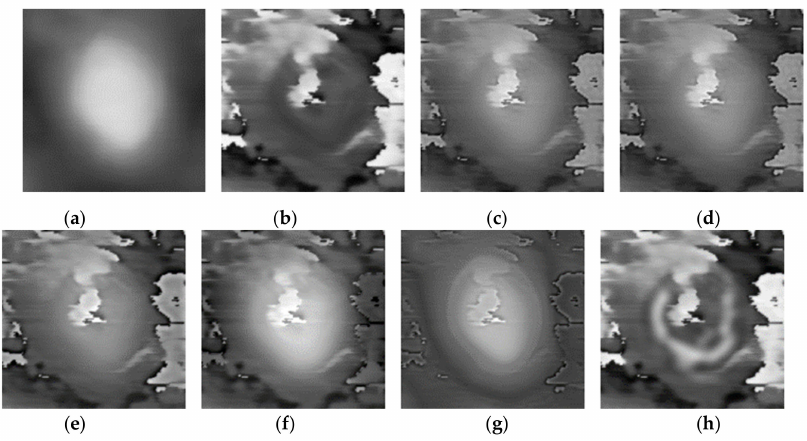
Figure 7. Fusion results of the “Data-3” image set with di ff erent methods. ( a ) Morphology; ( b ) Phase; ( c ) LP; ( d ) CVT; ( e ) NSST-VGG; ( f ) GFT; ( g ) FusionGAN; ( h ) proposed.